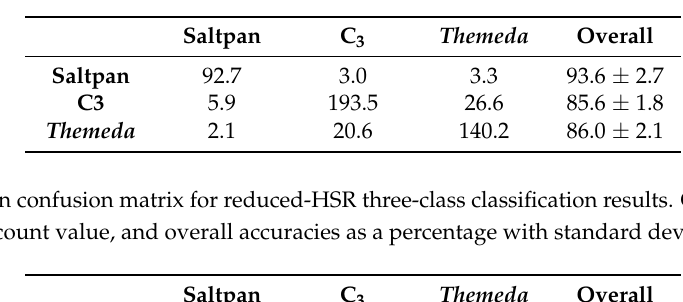
Table A1. Mean confusion matrix for full-HSR three-class classification results. Confusion values are given as a count value, and overall accuracies as a percentage with standard deviation.